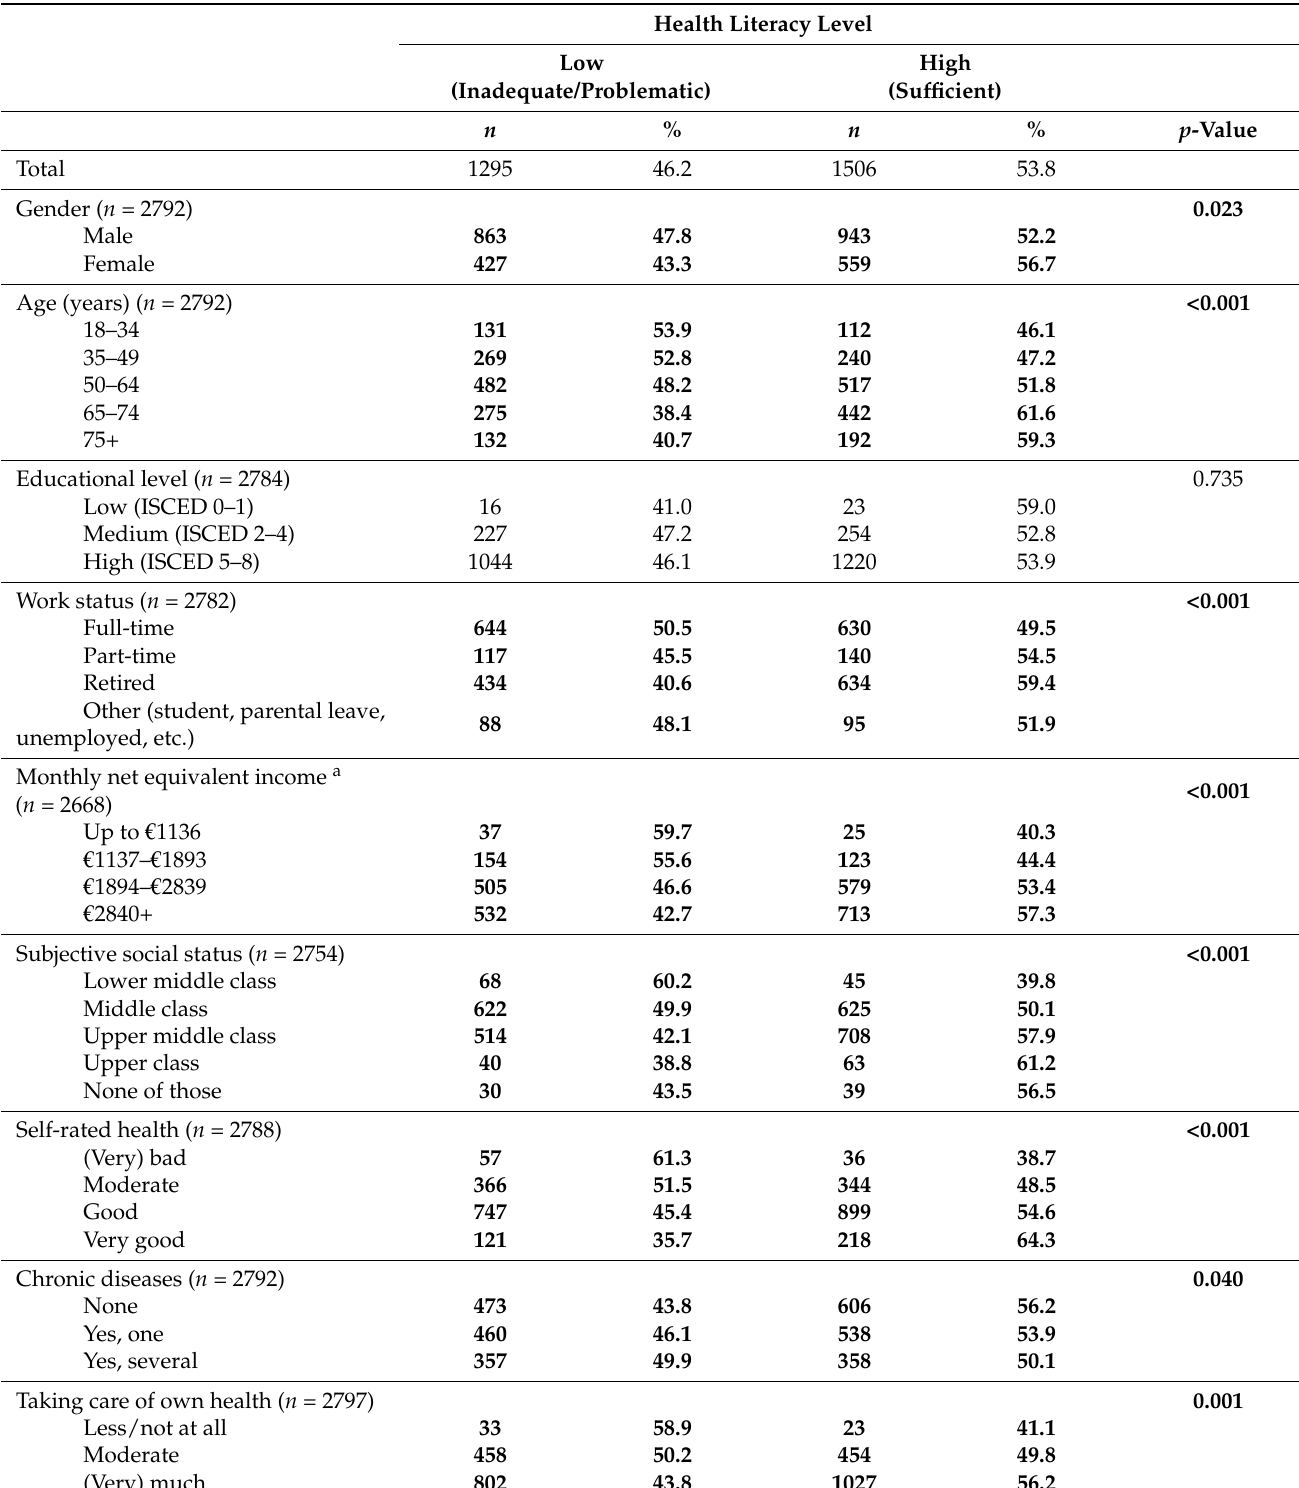
Table 3. Sample characteristics stratified by health literacy levels ( n =